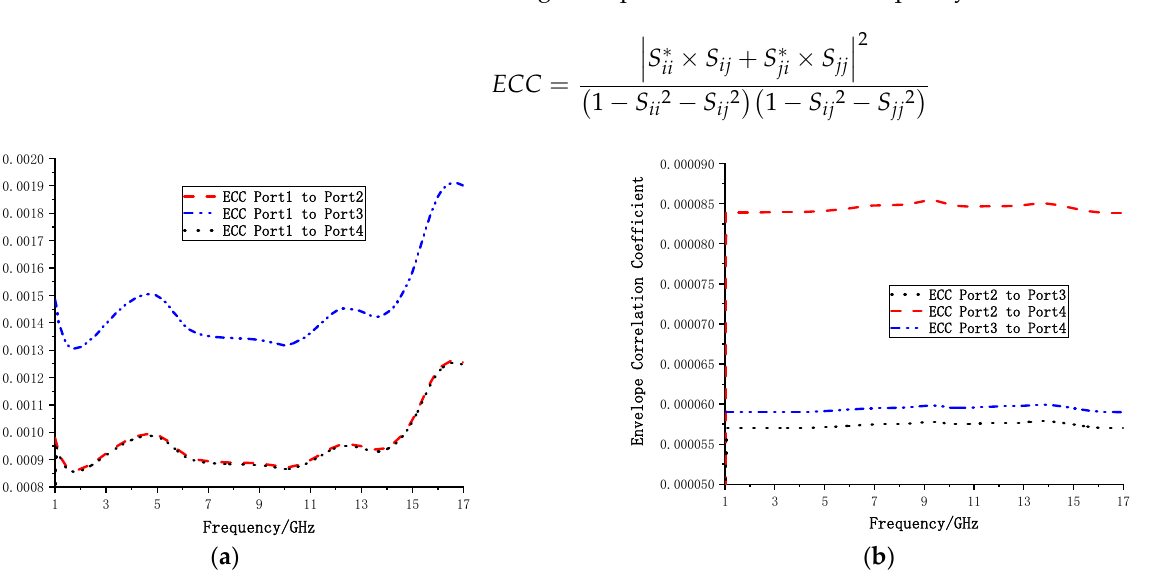
Figure 15. ECC between antenna units: ( a ) between port 1 and other ports; ( b ) between ports 2, 3, and 4.